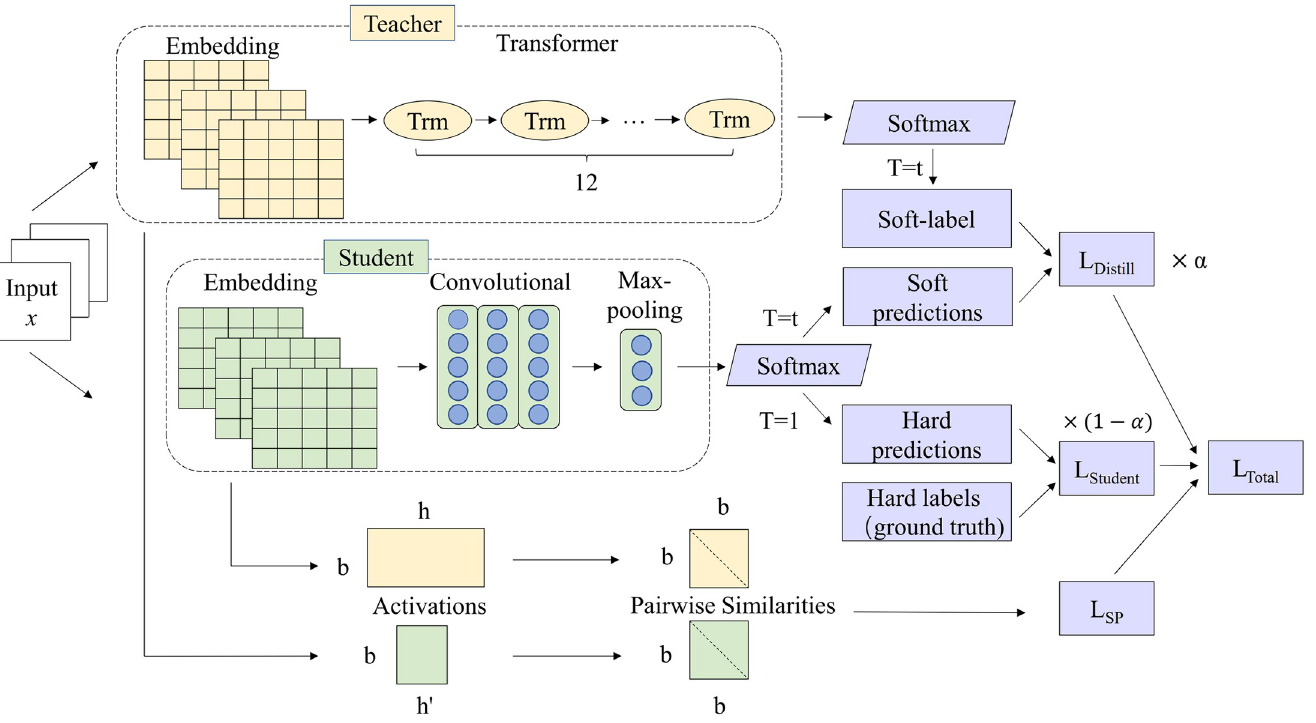
Fig 3. The structure of BERTtoCNN